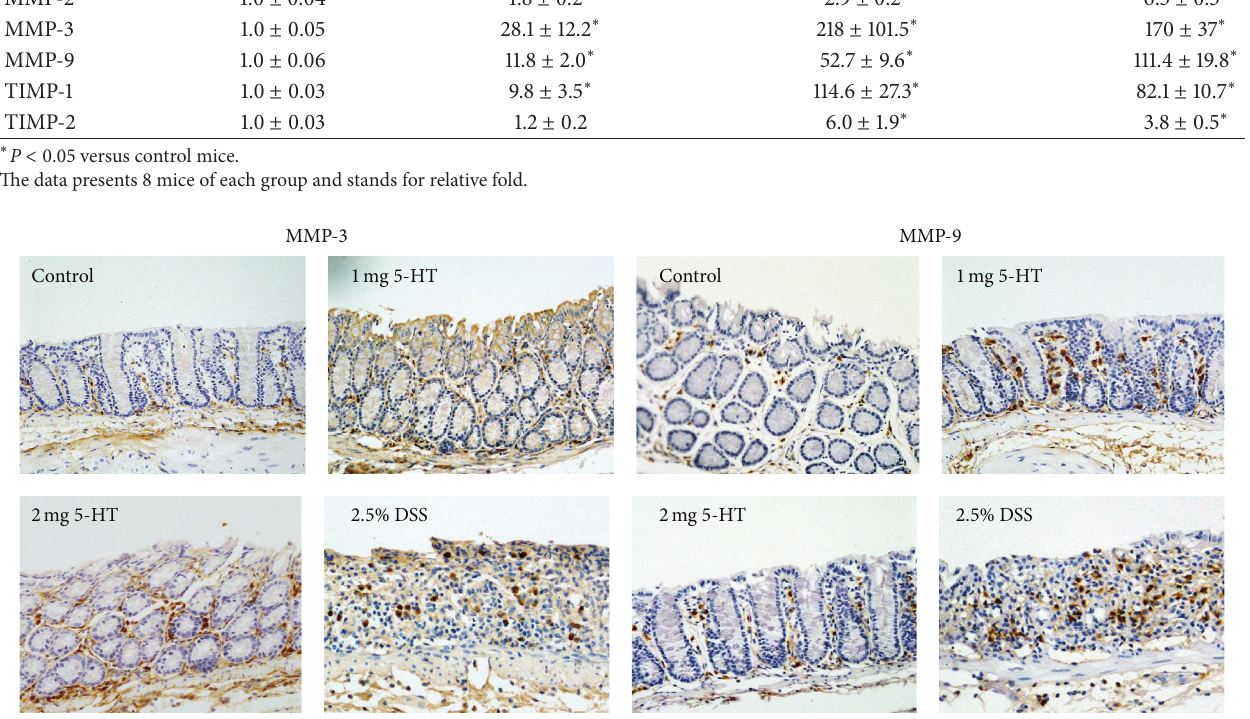
Figure 4: IHC staining of MMP-3 and MMP-9 in mouse colon tissue. The low expression MMP-3 was in colon tissue of control mice. The expression of MMP-3 was increased in the colon tissue of mice treated with high-dose 5-HT, further increased in severe inflammatory tissue. MMP-3 mainly located in infiltrating cells and stromal cells, some epithelial cell having weak staining. MMP-9 was increased in low 5-HT group but not in high-dose group and also highly increased in tissue with severe inflammation. MMP-9 was located mainly in inflammatory cells. Six mice from each group were included for IHC